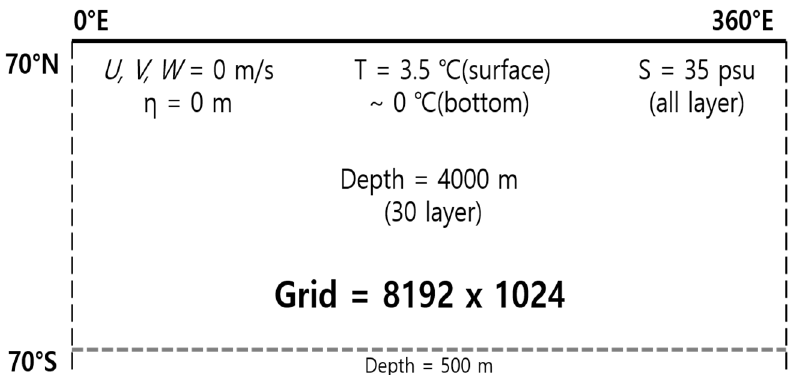
Figure 9. Ultra-high resolution experimental design using ROMS for an ideal case.